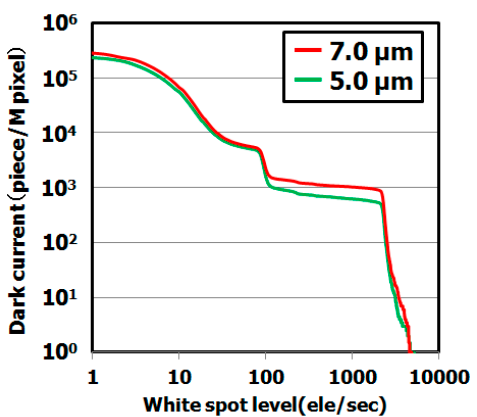
Figure 12. Dark current level of CMOS image sensor depending on epitaxial layer thickness. The dark current levels were measured by dark current spectroscopy under 60 °C. The hydrocarbon–molecular–ion dose amount is 1 × 10 15 cm − 2 .